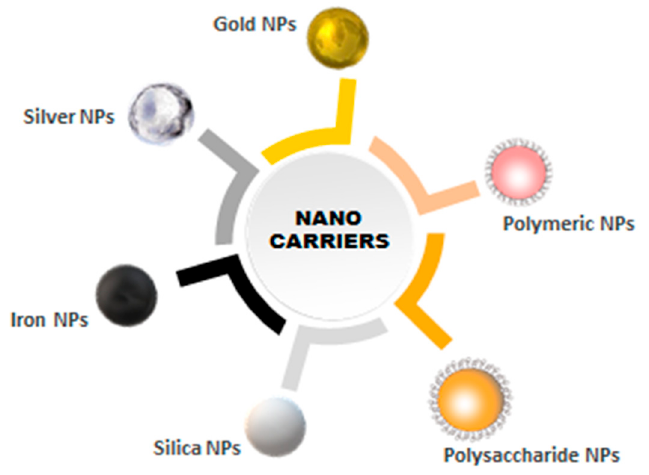
Figure 4. Di ff erent types of nanocarriers used for the preparation of Figure 4. Different types of nanocarriers used for the preparation of bioconjugates.